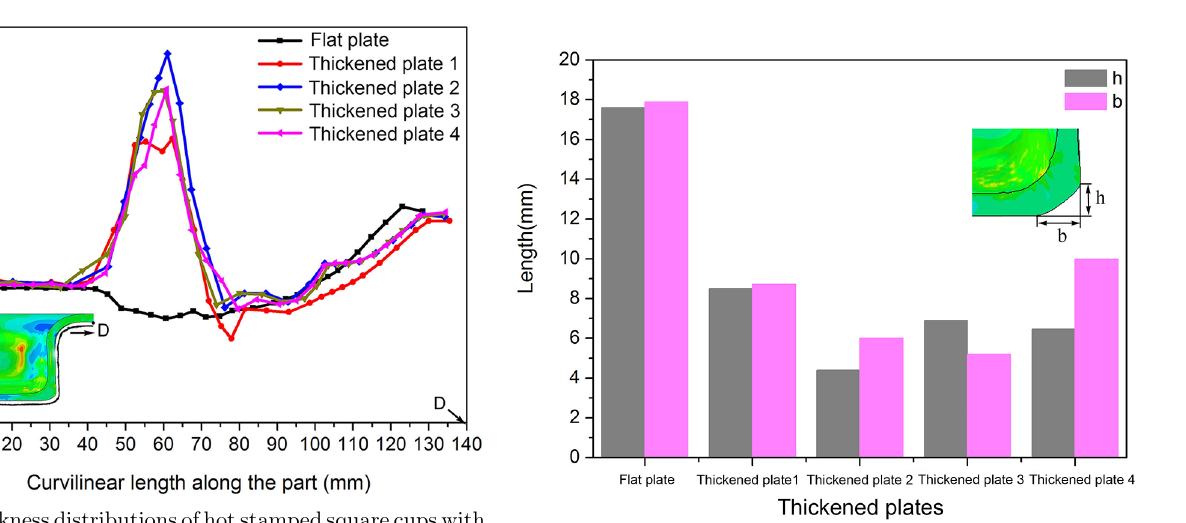
Fig. 16. The longitudinal section pro fi les of the bottom corners along the curve AD of hot stamped square cups with various thickened plates.